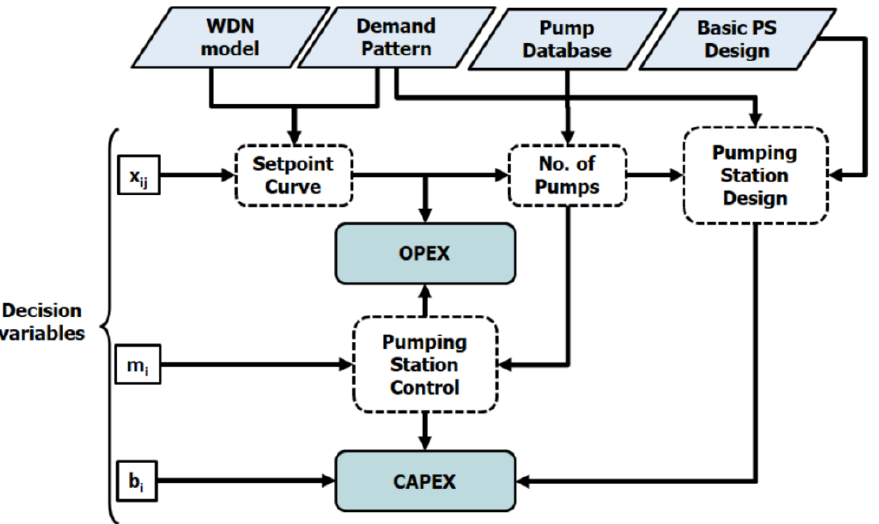
Figure 2. Calculation of OPEX and